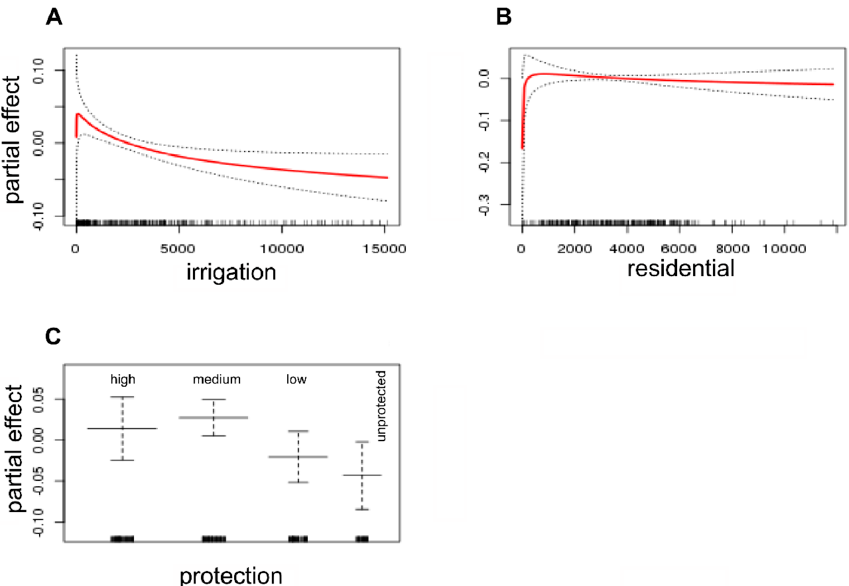
Figure 11. Partial effects of predictors in the best gam model for correlation between annual hydroperiod and precipitation (R-squared) for a random selection of natural water bodies. ( A ) Irrigation = smoothing spline of log distance to irrigated cultures; ( B ) residential = smoothing spline of log distance to residential areas; ( C ) protection = protection level (factor, four levels).